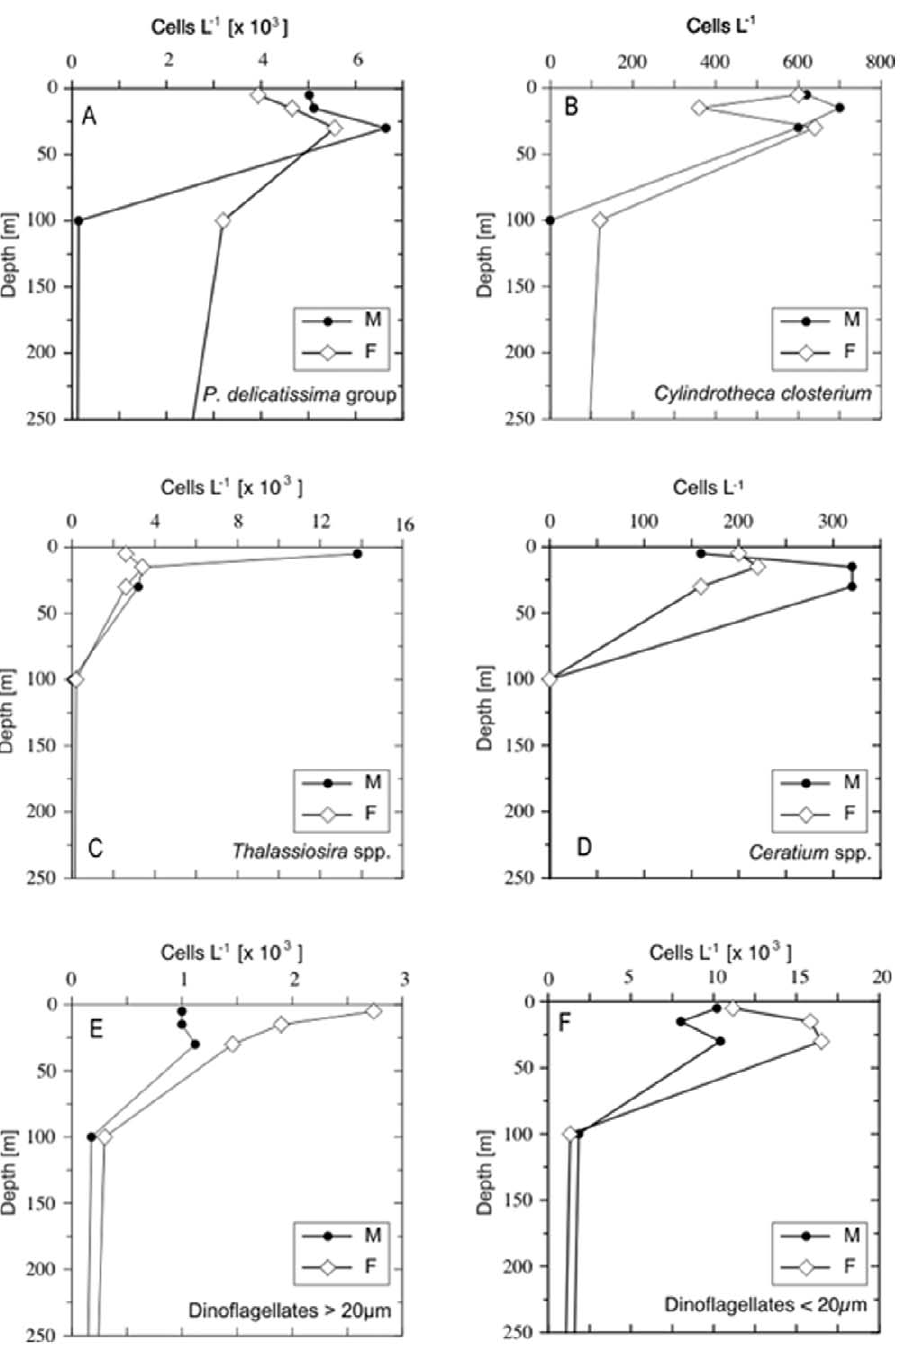
Figure 6. Depth profiles of cell densities off shelf. Abundances of the most abundant diatoms and dinoflagellates at station M and F within the top 250 m.